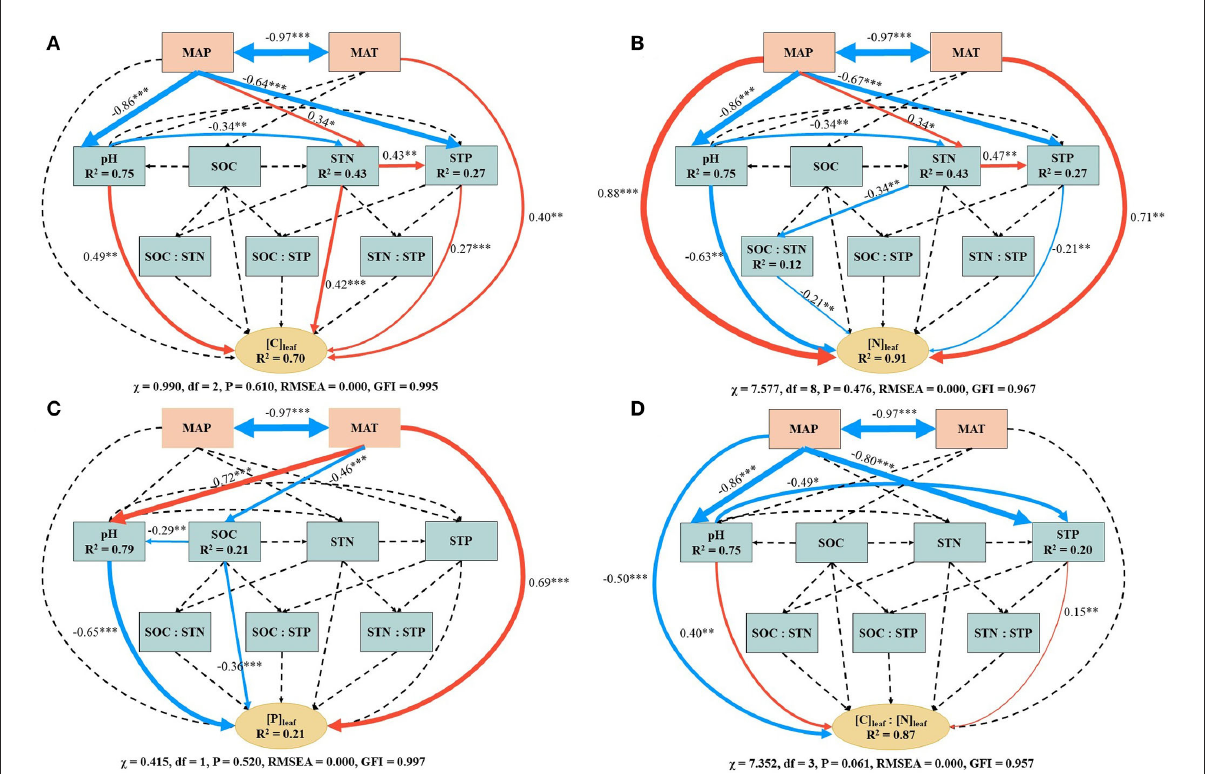
FIGURE3 Structural equation modeling (SEM) examining the climatic and soil effects on leaf carbon concentration (A) , leaf nitrogen concentration (B) , leaf phosphorus concentration (C) , and the ratio of leaf carbon concentration and leaf nitrogen concentration (D) . [C] leaf , leaf carbon concentration; [N] leaf , leaf nitrogen concentration; [P] leaf , leaf phosphorus concentration; SOC, soil organic carbon; STN, soil total nitrogen; STP, soil total phosphorus; MAT, mean annual temperature; MAP, mean annual precipitation. Single- and double-headed arrows represent the hypothesized causal direction and covarying variables, respectively. Continuous and dashed arrows indicate the relationships with (* P < 0.05, ** P < 0.01, *** P < 0.001) and without statistical significance ( P > 0.05), respectively. Numbers next to continuous arrows are standardized path coefficients, which indicate the effect size of the relationship. Red and blue arrows indicate the positive and negative relationships, respectively, and arrow width is scaled proportionally to their effect size. R 2 below variables indicates the proportion of variance explained.